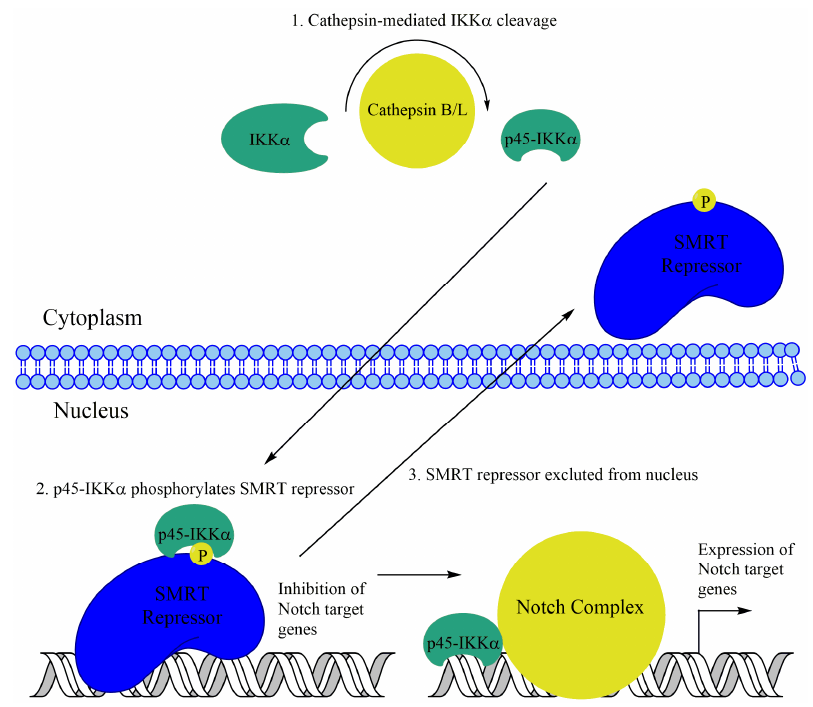
Figure 4. Nuclear IKK α promotes the expression of Notch target genes in colorectal cancer cells. A truncated p45-IKK α has been shown to phosphorylate the SMRT repressor, leading to its exclusion from the nucleus, leading to the expression of Notch target